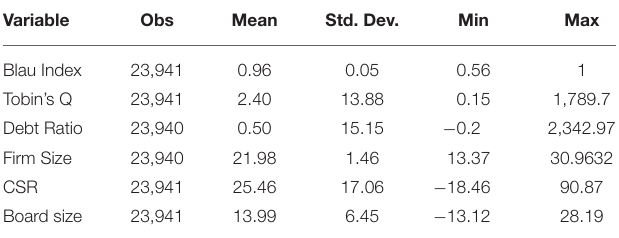
TABLE 2 | Descriptive